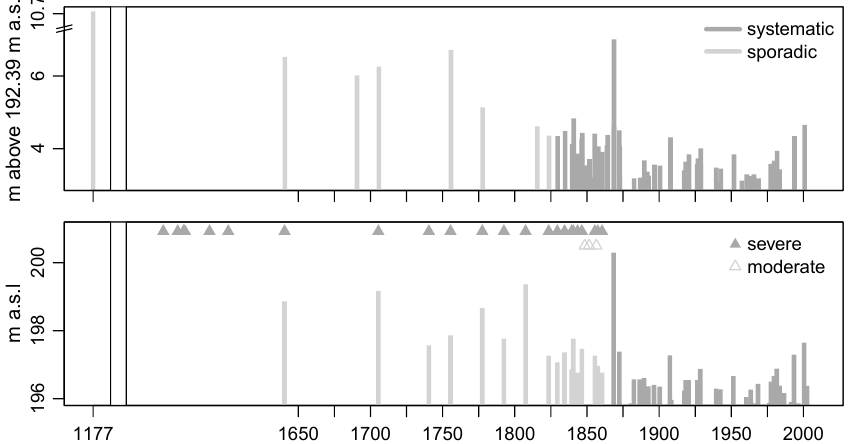
Figure 3. Reconstructed (light grey bars) and measured (dark grey bars) lake levels at Sesto Calende (top; data from Di Bella, 2005) and Locarno–Lago Maggiore (bottom; data from Stucki and Luterbacher, 2010). In addition, reconstructed flood events classified as “severe” (dark grey triangles) and “moderate” (light grey triangles) are shown for Lago